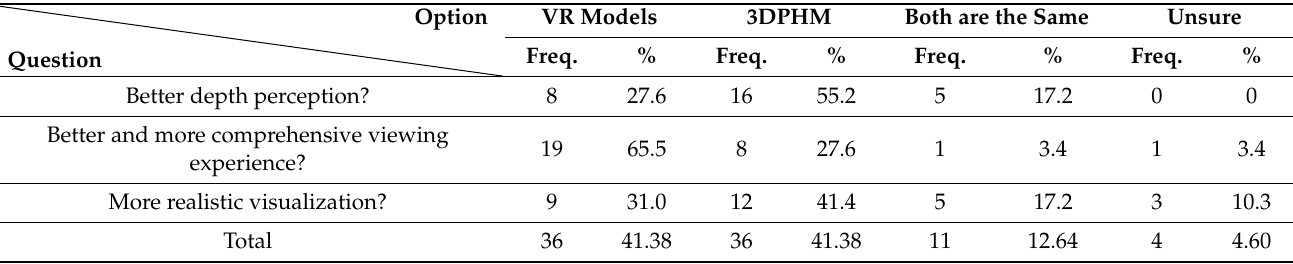
Table 2. Participants’ responses on the ability of VR and 3DPHM in displaying pathology and anatomy. Option Question Better appreciation of heart defects? Better understanding of the spatial relationship between cardiac structures? Better visualization of external cardiac structures? Better visualization of internal cardiac